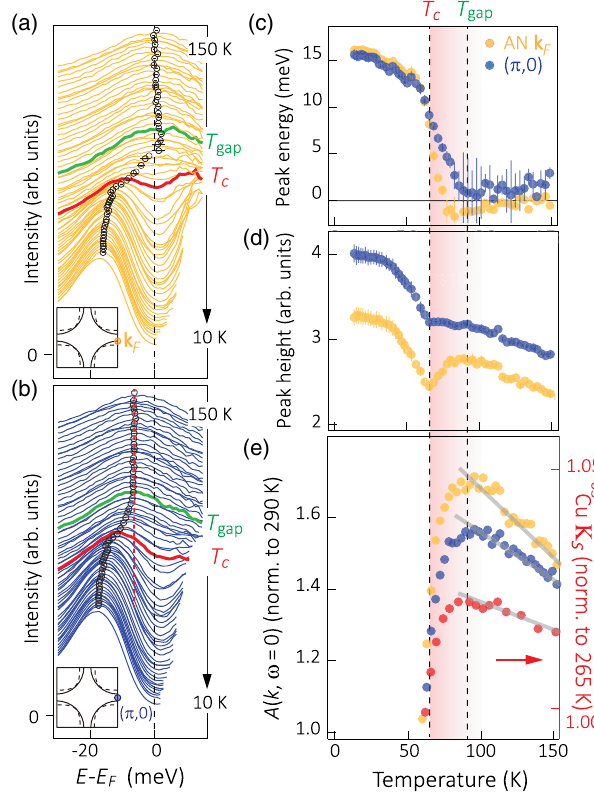
FIG. 4. Temperature dependence of the antinodal EDCs. Fermi- function-divided EDCs at (a) antinodal k and (b) ð π ; 0 Þ . Insets F depict the two momenta in the Brillouin zone. Spectra are normalized to 1 over [0, 100] meV binding energy. Green and ∼ 90 K and T ∼ 66 K, respectively. Black red lines denote T c gap circles mark the apparent spectral peak position, and the red dashed line marks the ungapped van Hove point position. Temperature-dependent (c) spectral peak binding energy, (d) spectral peak height, and (e) spectral intensity at E from F the antinodal k (yellow) and ð π ; 0 Þ (blue). Right-hand axis in F (e) corresponds to the frequency shift from the 63 Cu nuclear spin resonance (red). Gray lines are guides to exemplify normal state spectral weight evolution. Curves in (d) are offset for